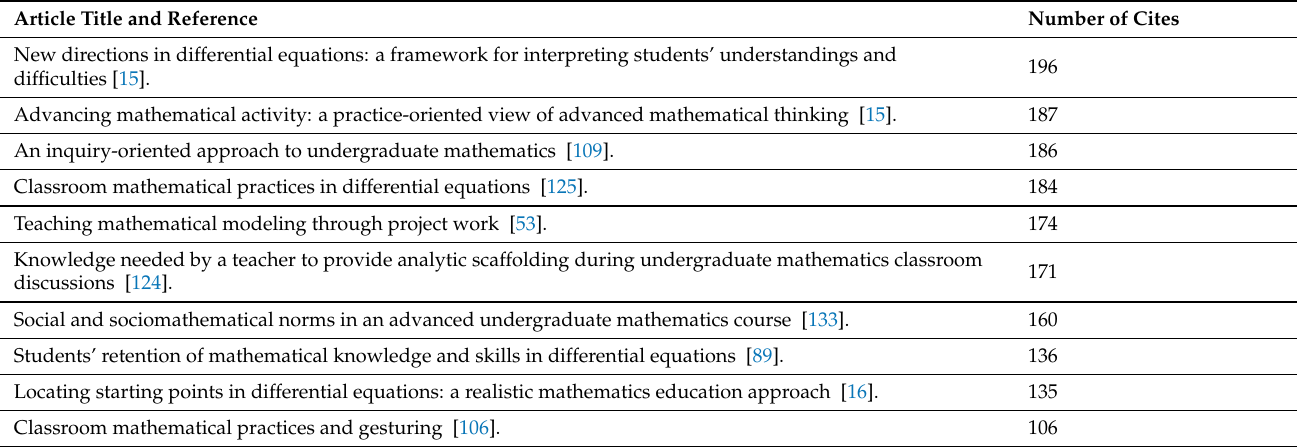
Table 5. Top 10 articles followed by the number of citations in Google